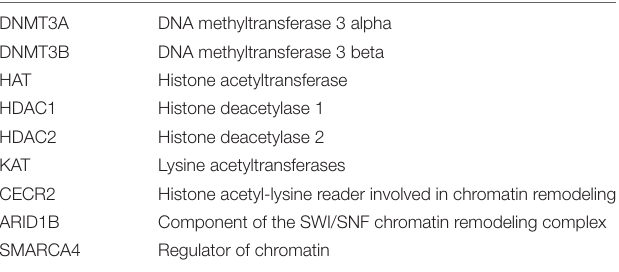
TABLE 1 | Epigenetic and chromatin-related factor defects implicated in neural tube defects (Greene et al., 2011). DNMT3A DNA methyltransferase 3 alpha